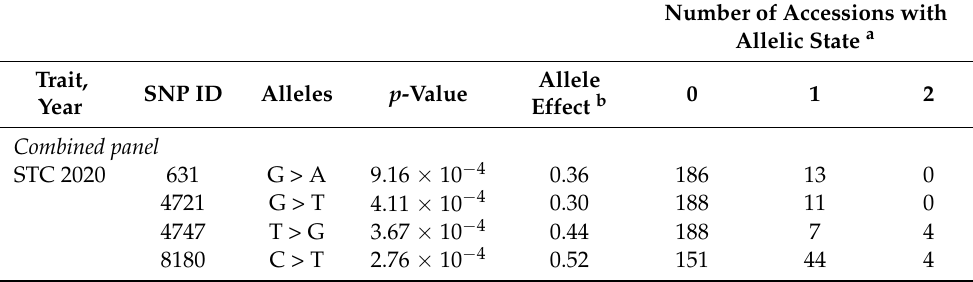
Table 5. p -Values, minor allele effects and numbers of accessions with each of the allelic states for SNPs found to be significantly associated with at least one stick-tight trait (STC or STI in 2020 or 2021) at p < 0.001 for either the combined, M. integrifolia , or M. tetraphylla panel. Allele effects are presented on back-transformed